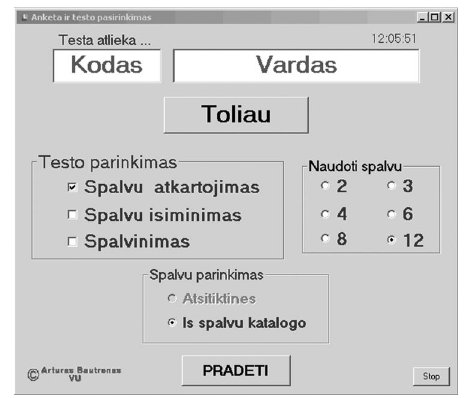
Fig 6. A window showing the test and the adjustment of its parameters